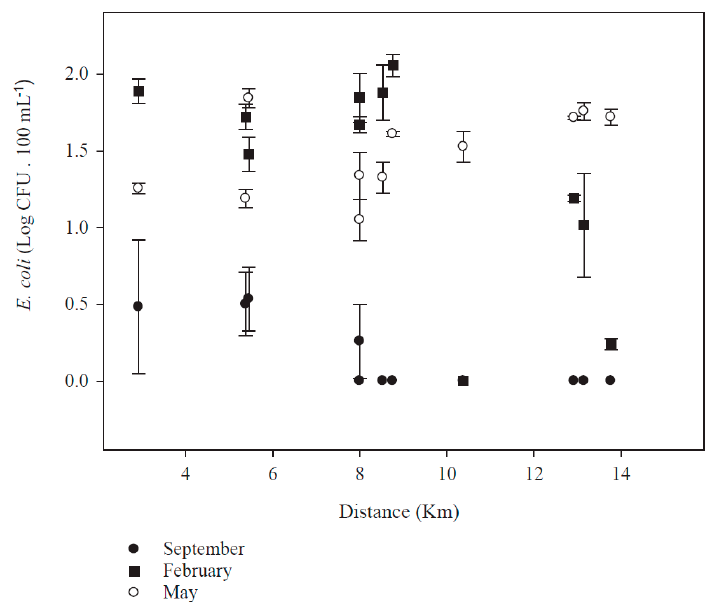
Figure 2. Presence of E. coli in reclaimed wastewater during different seasons from recreational parks at different distances from the wastewater treatment plant. Whisker lines represent the standard error.